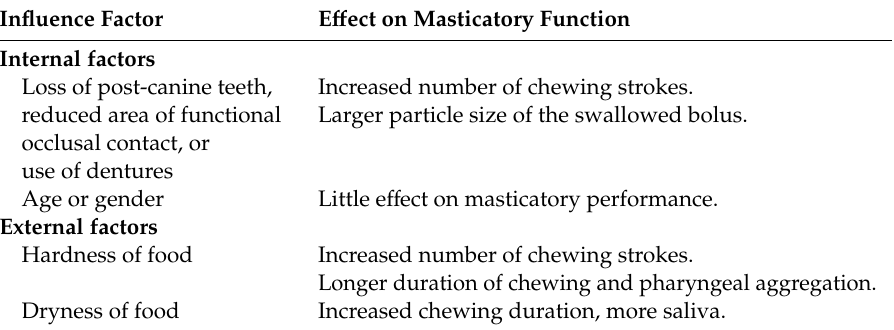
Table 2. Internal and external factors a ff ecting masticatory function